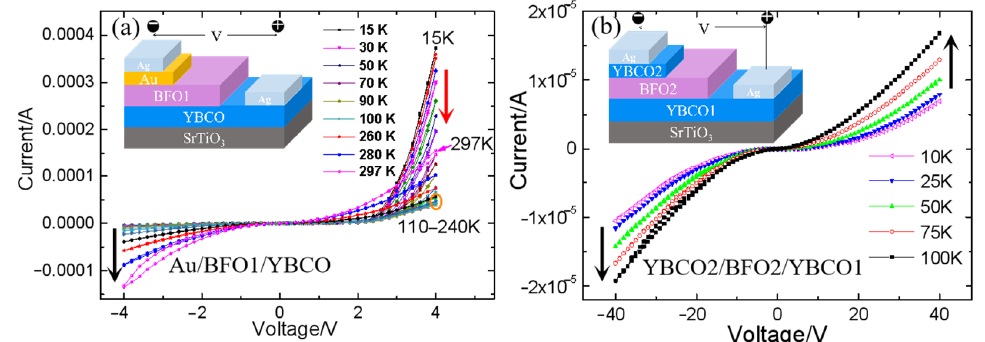
Figure 4. The current versus voltage curves of Au/BFO1/YBCO capacitor ( a ) and YBCO2/BFO2/YBCO1 capacitor ( b ) at different temperatures. The red down arrows illustrate the resistance increases with increasing the temperature, i.e., PTCR. The black vertical arrows indicate the absence of PTCR. The orange ellipse indicates the IV curves between 110–240 K. The inset illustrates the structure of the capacitor and the